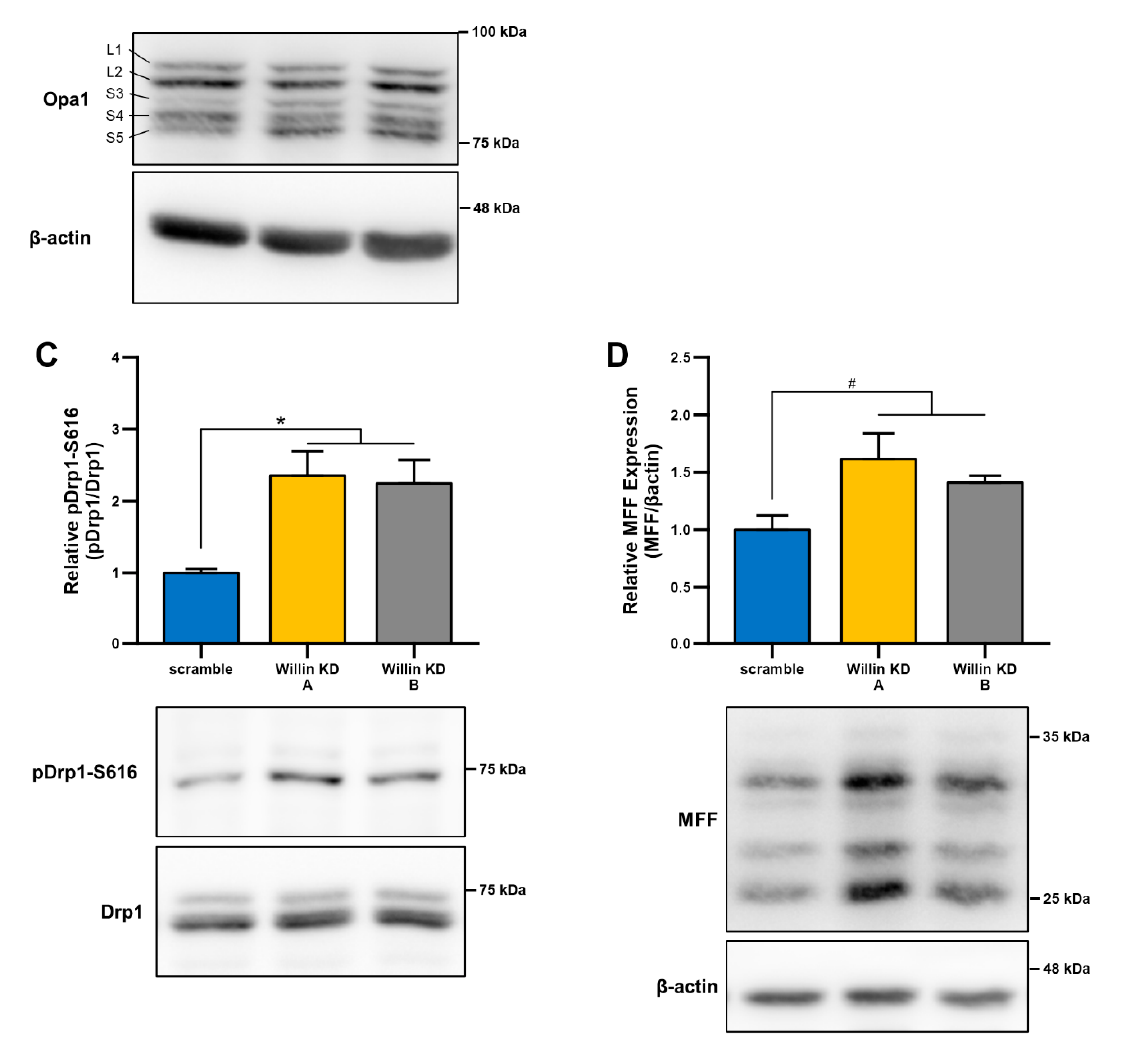
Figure 4. Downregulation of Willin/FRMD6 alters levels of mitochondrial fission and fusion proteins. ( A , B ) Quantification of OPA1 (S5) ( A ) and total OPA1 ( B ) immunoreactive bands relative to β -actin in the indicated cell lysates. Short isoforms of OPA1 are associated with mitochondrial fission. Data are expressed as fold change relative to the scramble group. n = 3 per group. ** p < 0.01. ns = no significant difference between all groups. ( C ) Quantification of phospho-DRP1-S616 immunoreactive bands normalized to total DRP1 in the indicated groups. Data are expressed as fold change relative to the scramble group. Representative immunoblots are shown underneath. n = 3 per group. * p < 0.05. ( D ) Quantification of MFF immunoreactive bands, normalized to β -actin in the indicated groups. Data are expressed as fold change relative to the scramble group. Representative immunoblots are shown underneath. n = 3 per group. # p < 0.1.